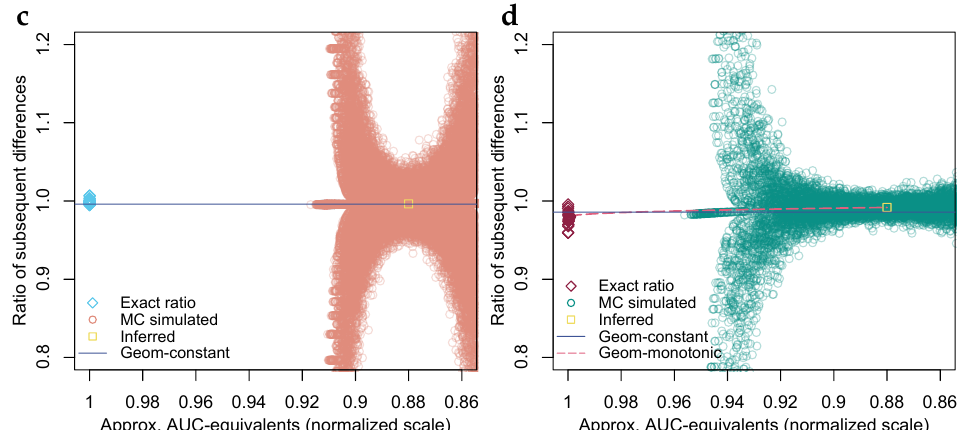
Figure 3. Geometric interpolation for cohorts with balanced and highly unbalanced numbers of TPs and TNs. ( a ) Monte Carlo-simulated AUC-value distribution functions for biomarkers on par with benchmark predicate FIT, with numbers of TPs and TNs 1004 and 800 (pan-cancer) and 93 and 800 (pancreatic). Critical values at 99% significance level, Bonferroni corrected for simultaneous testing of 53,352 hypotheses. ( b ) Upper 99.9th percentile of ( a ), with MC-simulation and exact computation bridged by geometric interpolations. For a pancreatic cohort, an alternative interpolation with a monotonically increasing geometric coefficient is included. ( c ) Ratio of subsequent differences for pan-cancer cohort, with a ratio inferred from the median of the S-shaped distribution function at AUC 0.88. ( d ) Ratio of subsequent differences for the pancreatic cohort, with a non-constant geometric coefficient, connecting the exactly computed ratios with the inferred ratio through a monotonically increasing positive exponent function.